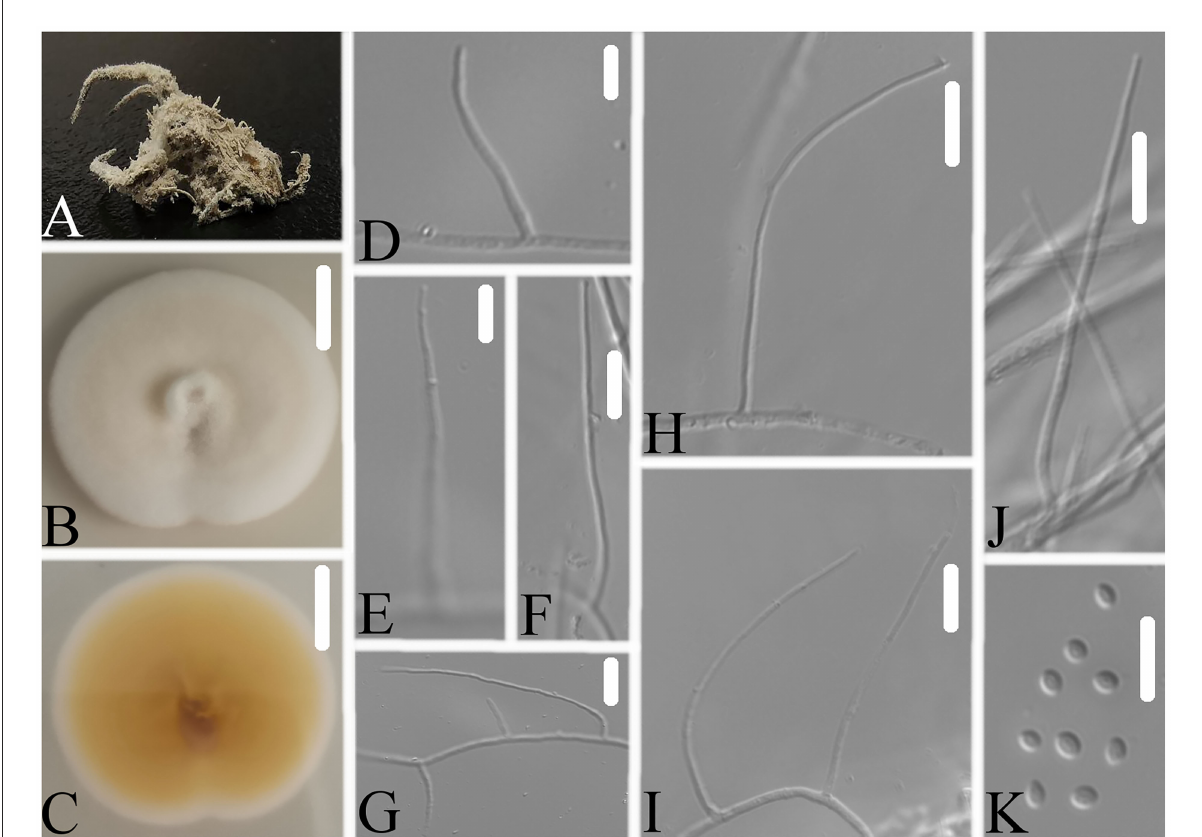
FIGURE4 Simplicillium araneae (A) Infected spider (Araneae); (B,C) PDA-containing culture plate showing the front (B) and reverse (C) sides of the colony; (D–K) solitary phialides and conidia. Scale bars: 10mm (B,C) and 10 µ m (D–K) .